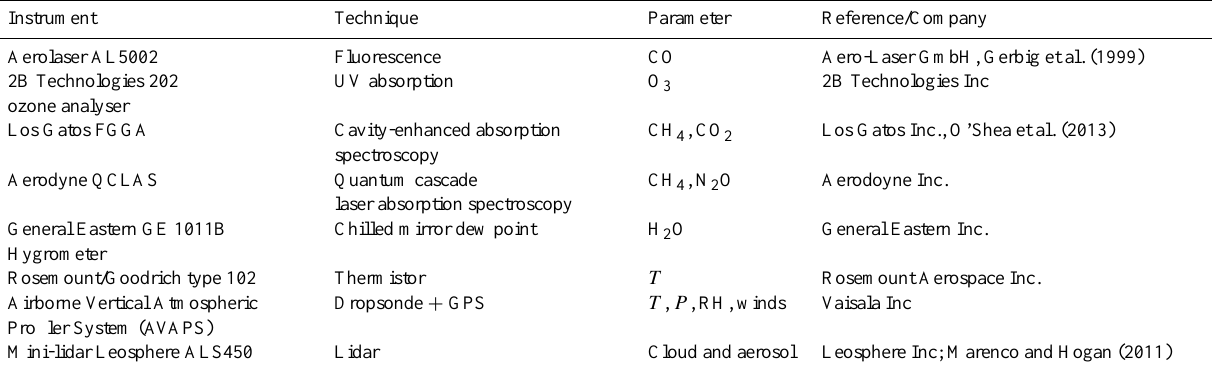
Table 1. BAe-146 thermodynamic and trace-gas instruments used in this study. T , P and RH refer to ambient temperature, pressure and relative humidity,